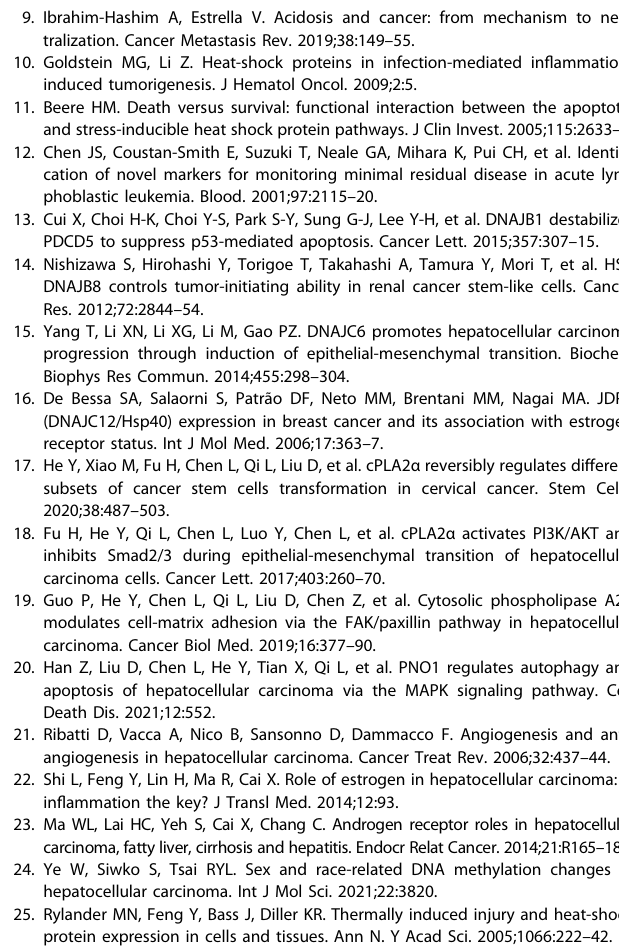
Fig. 7 Schematic model of research conclusions. Extracellular stress could upregulate DNAJC24 expression through transcriptional regulation of HSF2 and targeting DNAJC24 can affect the autophagy and proliferation of HCC cells by decreasing the expression of CPS1, the fi rst key enzyme of the urea